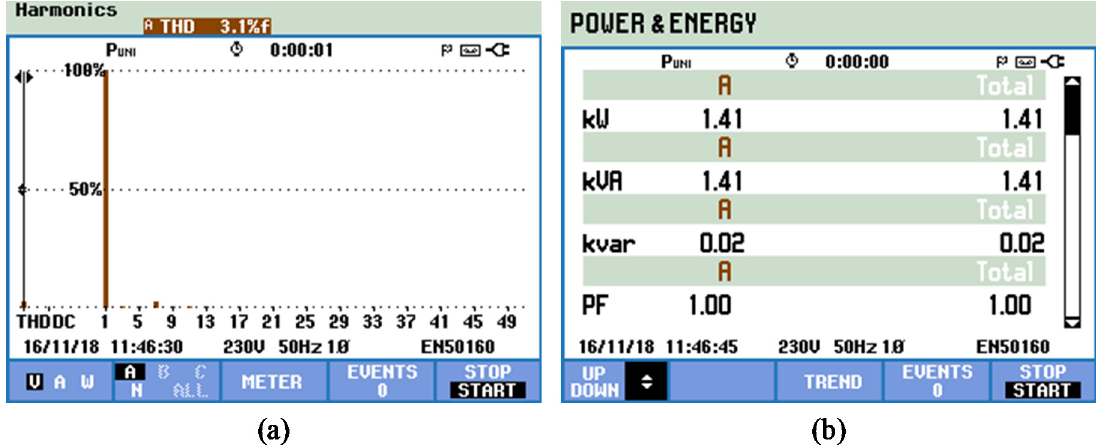
Figure 3. Experimental results during the MF-EVCS operation in G2V mode: Ac-side voltage ( v g : 50 V/div) and ac-side current ( i evcs : 10 A/div).